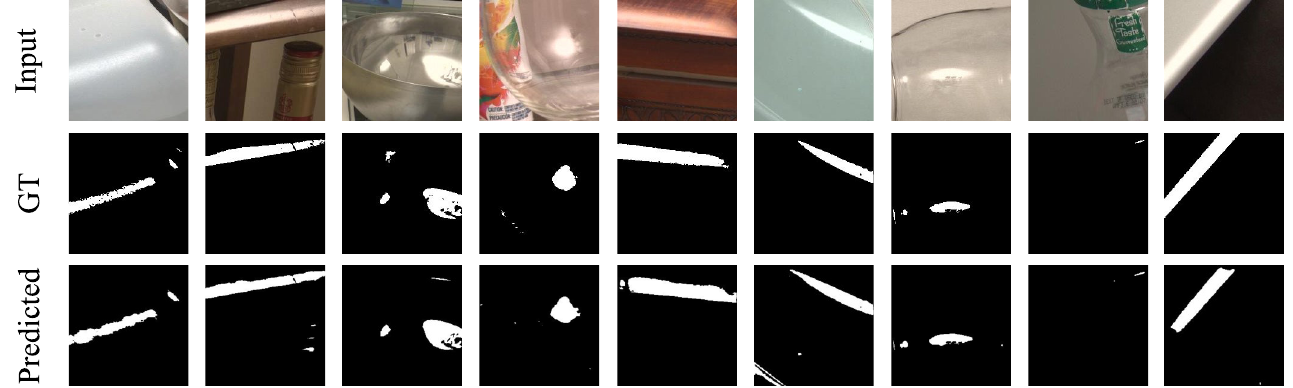
Figure 6. Segmentation results of SpecSeg network as compared to manually labelled Ground Truths (GT) in the SIHQ dataset [49].